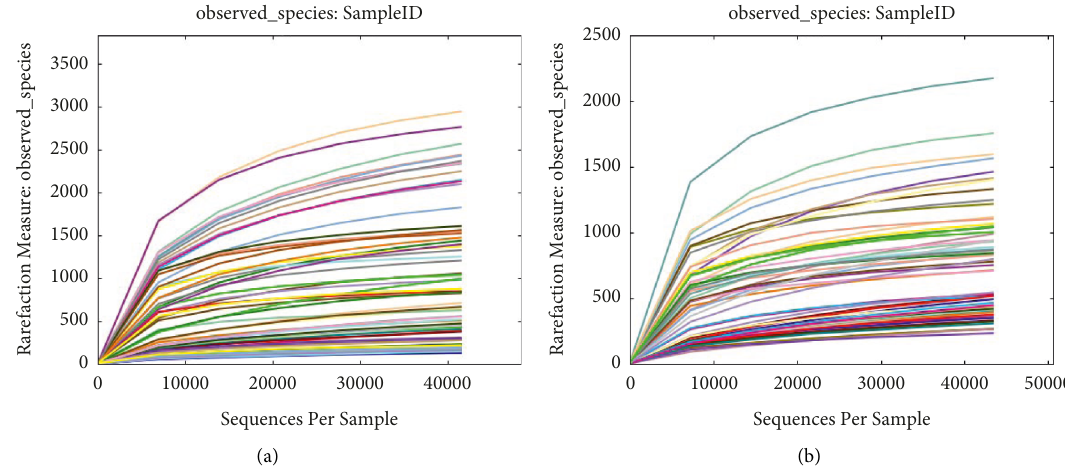
Figure 3: Dilution curve of bacteria of infant milk formula production line samples in spring ((a), n � 70) and summer ((b), n �